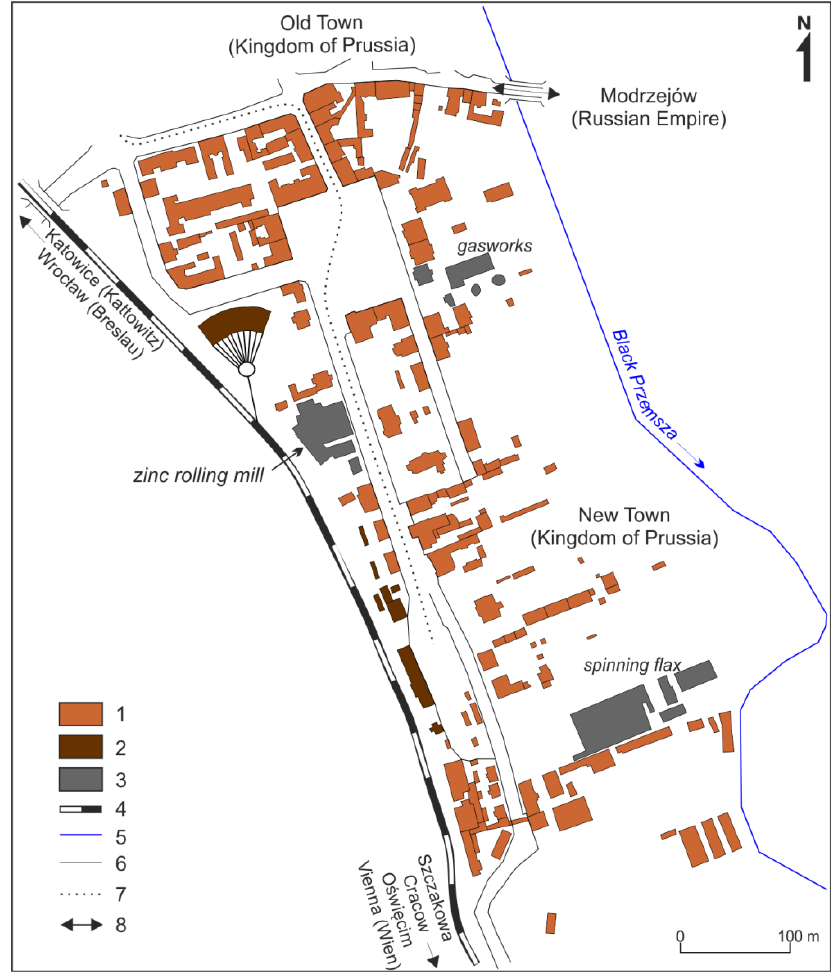
Fig. 2. Spatial arrangement of the New Town area in Mysłowice at the beginning of the 20 th century 1 – dwelling houses and public buildings; 2 – railway buildings; 3 – industrial buildings; 4 – railway line; 5 – river; 6 – streets; 7 – tram line; 8 – border crossing between Prussia and the Polish Kingdom